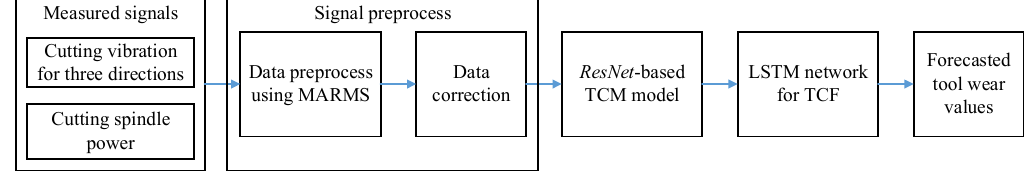
Figure 1. Framework of TCF methodologies.